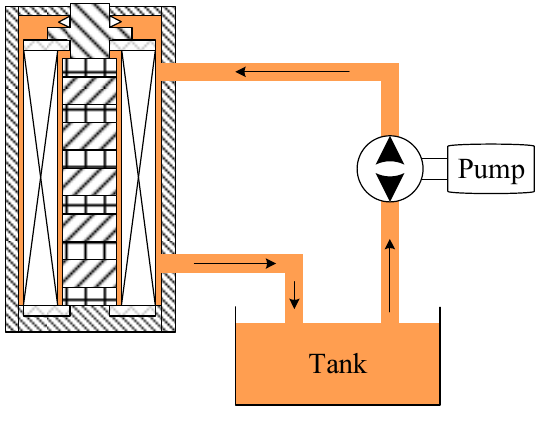
Figure 12. The cooling system.